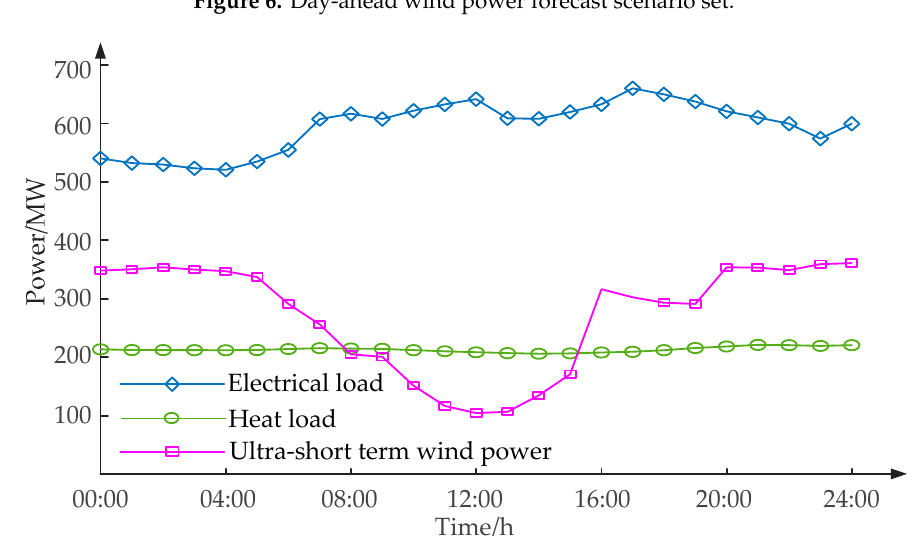
Figure 7. Intra-day wind power forecasting curve and electric/heat load curve.